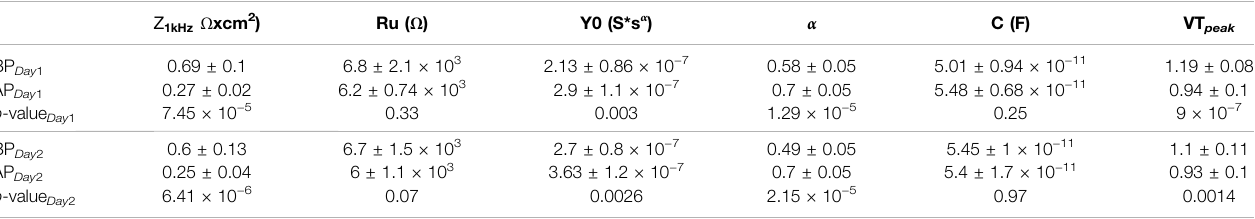
TABLE 1 | Mean and standard deviation of the normalized impedance at 1 kHz, list of all components extracted from the equivalent circuit model (see inset of Figure 5A ), VT peak for Day 1 and Day 2 before and after pulsing. The p -value from the paired t-test are reported with a signi fi cance difference for the constant phase element components as well as for normalized impedance at 1 kHz and the VT peak before and after pulsing on Day 1 and Day